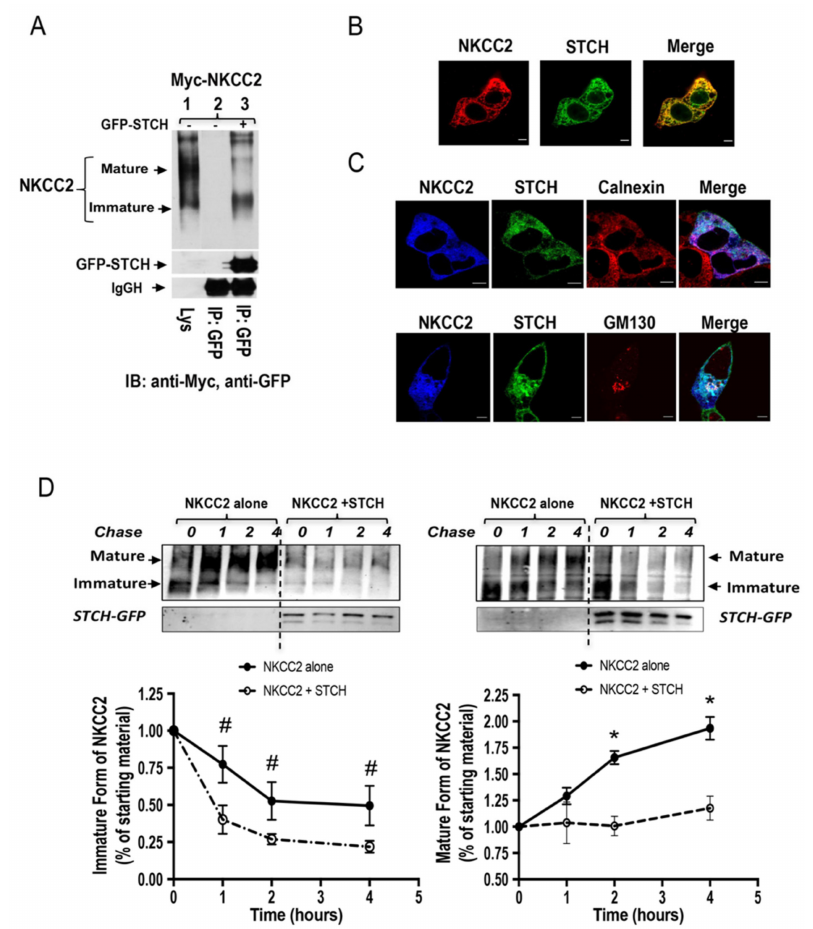
Figure 4. The effect of STCH on NKCC2 expression is independent of the expression system. ( A ) STCH interacts with immature NKCC2 in OKP cells. Cells were transiently transfected with Myc-NKCC2 either singly or in combination with GFP-STCH construct. Cell lysates were immunopre- cipitated (IP) with anti-GFP antibody. NKCC2 protein was recovered from STCH immunoprecipitates mainly in its immature form ( lane 3 ). ( B ) Imunofluorescence confocal microscopy showing distri- bution of Myc-NKCC2 and GFP-STCH in OKP cells. Cells were stained with mouse anti-Myc for NKCC2 (Texas Red). The yellow color (merged image) indicates co-localization of the proteins. Bars, 5 µ m. ( C ) Similar to HEK cells, STCH and NKCC2 co-localizes mainly at the ER in OKP cells. All panels are fluorescence micrographs of OKP cells overexpressing myc-NKCC2 and GFP- STCH. Upper panel , fixed and permeabilized cells were stained with mouse anti-Myc and rabbit anti-calnexin (ER marker) antibodies. The merge color indicates overlap between the Myc tag of NKCC2 protein (Alexa Fluor 647, Blue), the GFP tag of STCH (green), and the ER marker (Alexa Fluor 555, red) and represents co-localization of the proteins. In lower panel , fixed and permeabilized cells were stained with mouse anti-Myc and rabbit anti-GM130 (cis-Golgi marker) antibodies. The merge color indicates overlap between the Myc tag of NKCC2 protein (Alexa Fluor 647, Blue), the GFP tag of STCH (green), and the cis-Golgi marker (Alexa Fluor 555, red) and represents co-localization of the proteins. In addition to the ER, the interaction between NKCC2 and STCH may also occur at the cis-Golgi. Analysis was performed by confocal laser scanning microscopy. Bars, 5 µ m. ( D ) Analysis of NKCC2 stability and maturation monitored by cycloheximide-chase upon STCH expression. OKP cells were co-transfected with NKCC2 together with a control vector or GFP-STCH construct. Then, 14 h later, cell lysates were prepared at the indicated time points after cycloheximide treatment (100 µ M). Total protein extracts are subjected to SDS-PAGE and probed using anti-Myc antibody. The density of the mature and immature forms of NKCC2 proteins was normalized to the density at time 0. #, *; p < 0.05 ( n = 3) versus